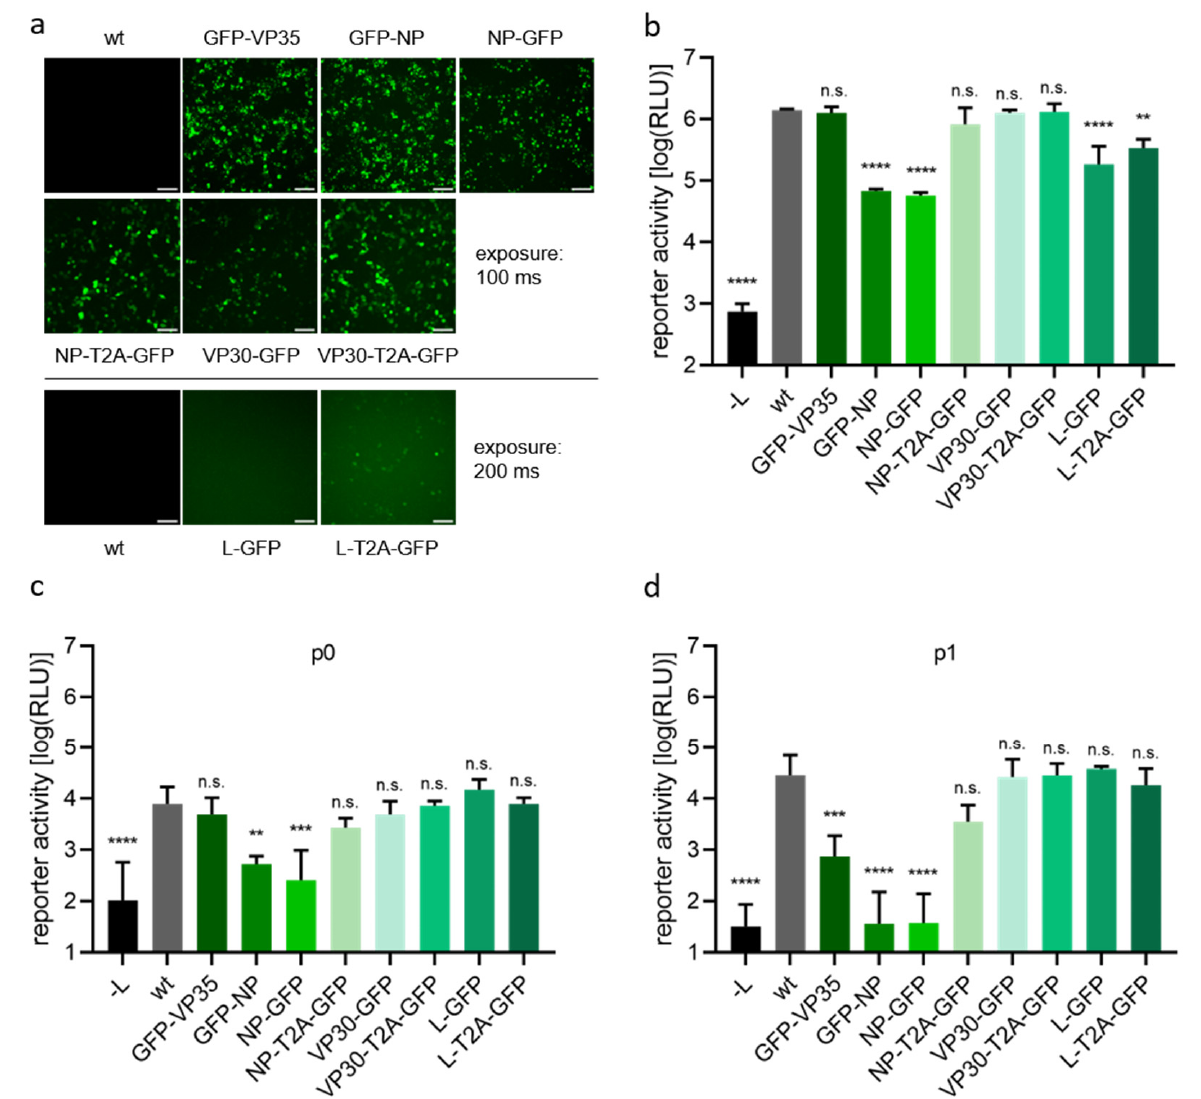
Figure 3. Characterization and functionality of GFP-tagged EBOV RNP proteins. ( a ) Visualization of fluorescence. 293T cells were transfected with all components for a 4-cis minigenome assay. Indicated expression plasmids of RNP proteins were replaced by expression plasmids encoding RNP proteins directly tagged with GFP or proteins GFP-tagged via a T2A site. 48 h after transfection expression of GFP was analyzed by fluorescence microscopy. Scale bar: 100 µm. ( b ) Analysis of protein functionality in a 1-cis minigenome assay. 293T cells were transfected with all components for a 1-cis minigenome assay, including expression plasmids for tagged RNP proteins instead of wild type (wt) proteins as indicated. Cells were lysed 48 h after transfection, and minigenome reporter activity was measured. As a negative control, expression plasmid for L was omitted (-L). ( c , d ) Analysis of protein functionality in a 4-cis minigenome assay. 293T cells were transfected with all components for a 4-cis minigenome assay. Lysis and measurement of reporter activity in p0 cells ( c ) was performed 72 h after transfection, while p1 cells were assessed 72 h after infection ( d ). The polymerase expression plasmid was replaced by empty vector as a negative control (-L). Means and standard deviations of three biological replicates ( b – d ) or a representative of three biological replicates ( a ) are shown. Significant differences compared to wt are indicated: n.s.: not significant; **: p < 0.01; ***: p < 0.001; ****: p < 0.0001.